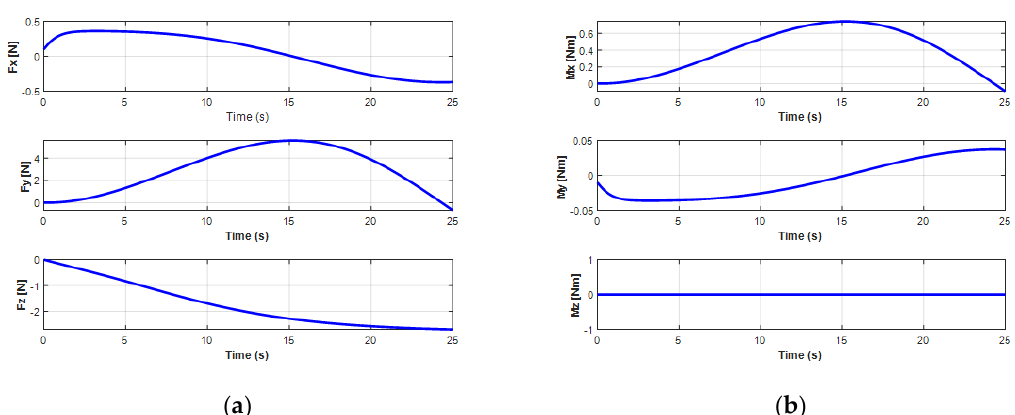
Figure 22. Cable forces and moments affecting USV turning motion: ( a ) forces of the UC on the USV; ( b ) moments of the UC on the USV.